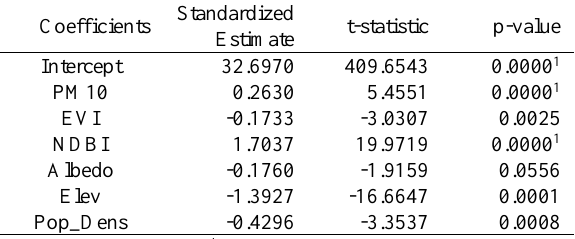
Table 7. 75 th quantile regression results.